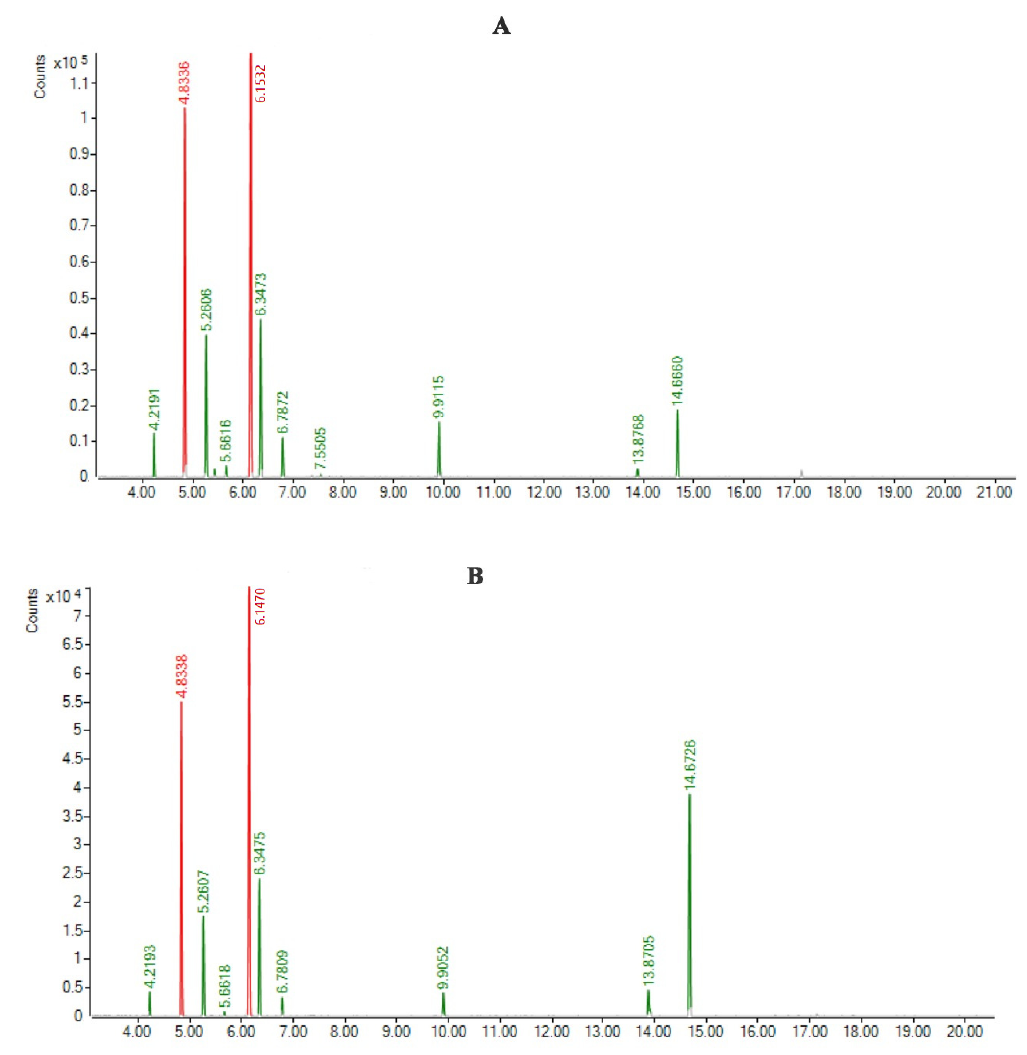
Figure 1. GC chromatogram of AFO obtained from fresh ( A ) and dried ( B ) plant samples.